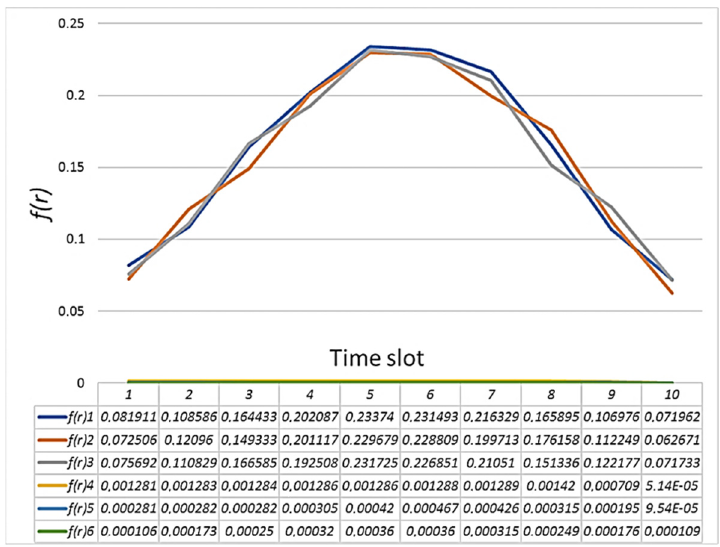
Figure 11. The result of calculating the normal distribution function for the incoming traffic of node i under conditions of a SYN flood attack.